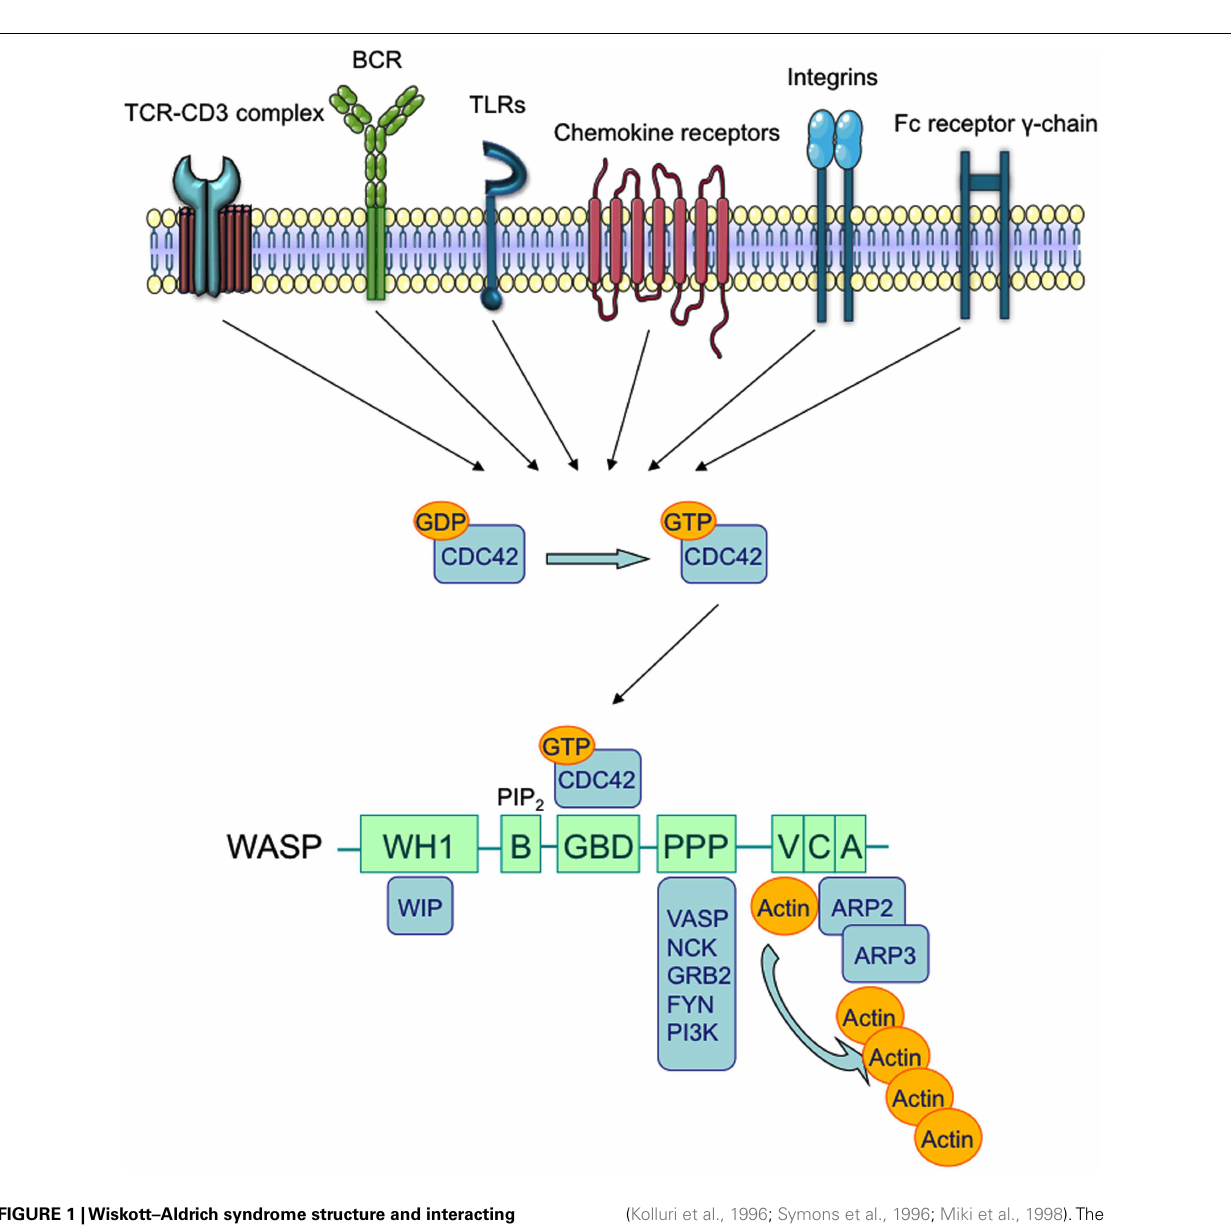
(Kolluri et al., 1996; Symons et al., 1996; Miki et al., 1998).The proline-rich region (PPP) provides binding sites for the Vasodilator-Stimulated Phosphoprotein (VASP), and also for SRC family tyrosine kinases and SRC Homology 3 (SH3) domain-containing proteins such as the adaptor proteins GRB2, FYN, PI3K, and NCK.The Verprolin-homology (V) domain binds to actin monomers, and the Cofilin-homology (C) and Acidic (A) domains bind to the Actin-Related Protein (ARP)2/3 complex.TheV/C/A region functions as the platform to initiate actin polymerization (Park et al.,